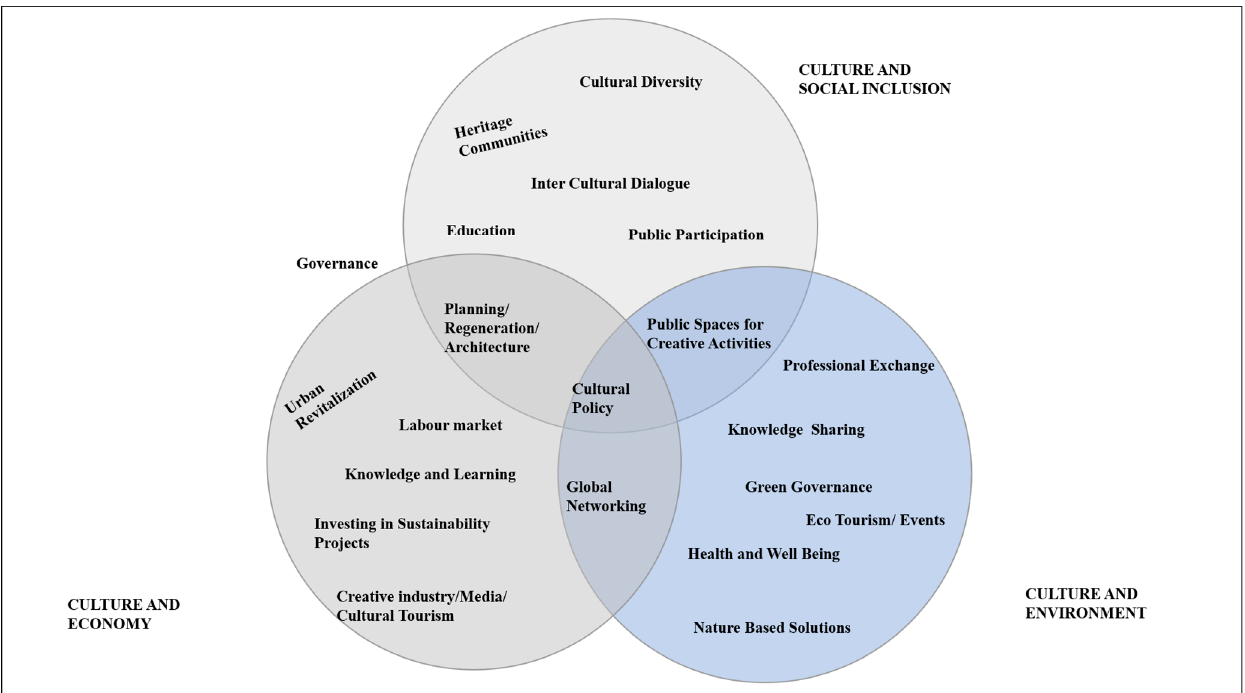
Figure 1. Culture and Sustainable Development Action Plan. Source: Author.